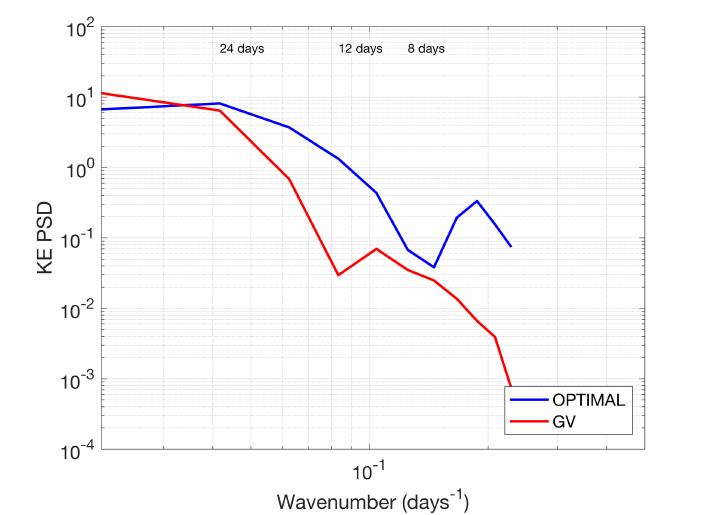
Figure 14. Temporal spectral content of the Optimal currents (blue) and GV (red) kinetic energy (west